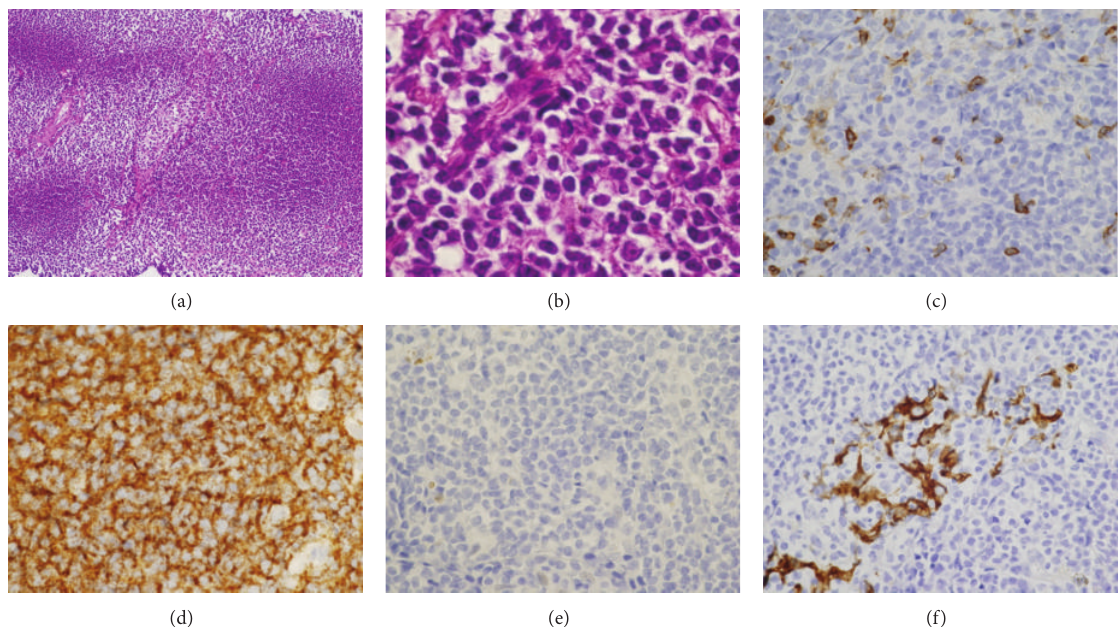
Figure 3: Microscopic findings of lung biopsy specimens with hematoxylin and eosin staining ((a) × 10; (b) × 80). Immunohistochemical examinations of the tissue were positive for CD20 ((d) × 40) and negative for CD5 ((c) × 40), bcl-1 ((e) × 40), and AE1/AE3 ((f) ×